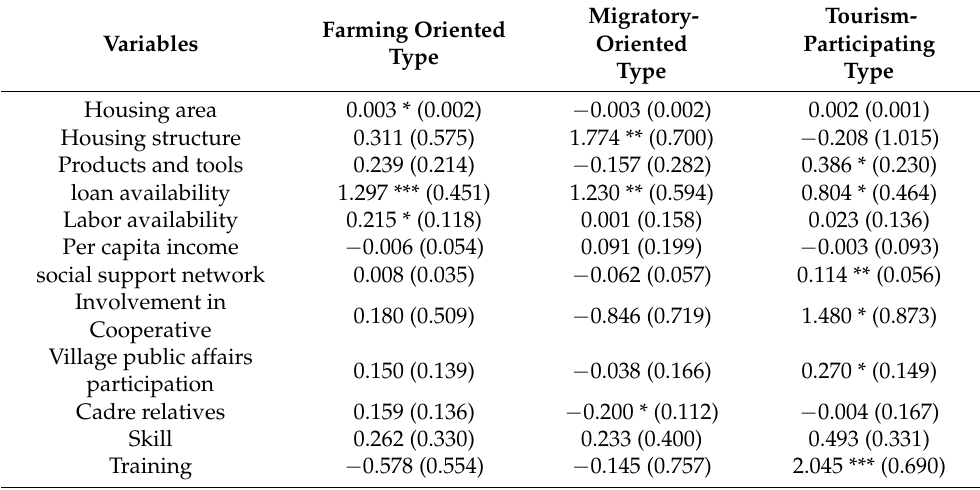
Table 6. Differences in the influencing factors of different types of rural households’ willingness to participate in rural tourism (in